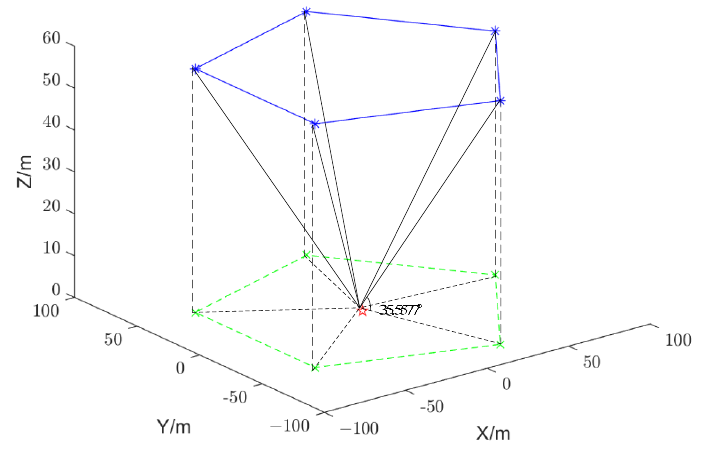
Figure 2. Multi-station AOA positioning optimal deployment schematic. Red